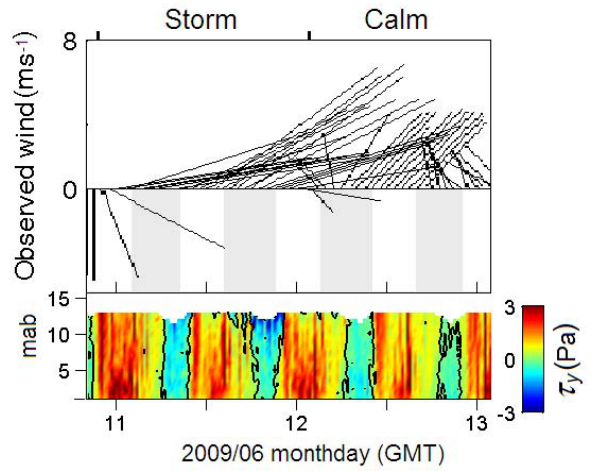
Fig.10. Time series of wind (stick diagram - upper panel) and time-depth variations of the 3 Fig. 10. Time series of wind (stick diagram – upper panel) and time- depth variations of the along-shore wave-corrected stress (lower along-shore wave-corrected stress (lower panel) indicating a significant growth of turbulent 4 panel) indicating a significant growth of turbulent intensity in the intensity in the upper layer on ebb flow under southwestern winds during storm period. Ebb 5 upper layer on ebb flow under southwestern winds during storm pe- riod. Ebb periods are shaded. periods are shaded. 6